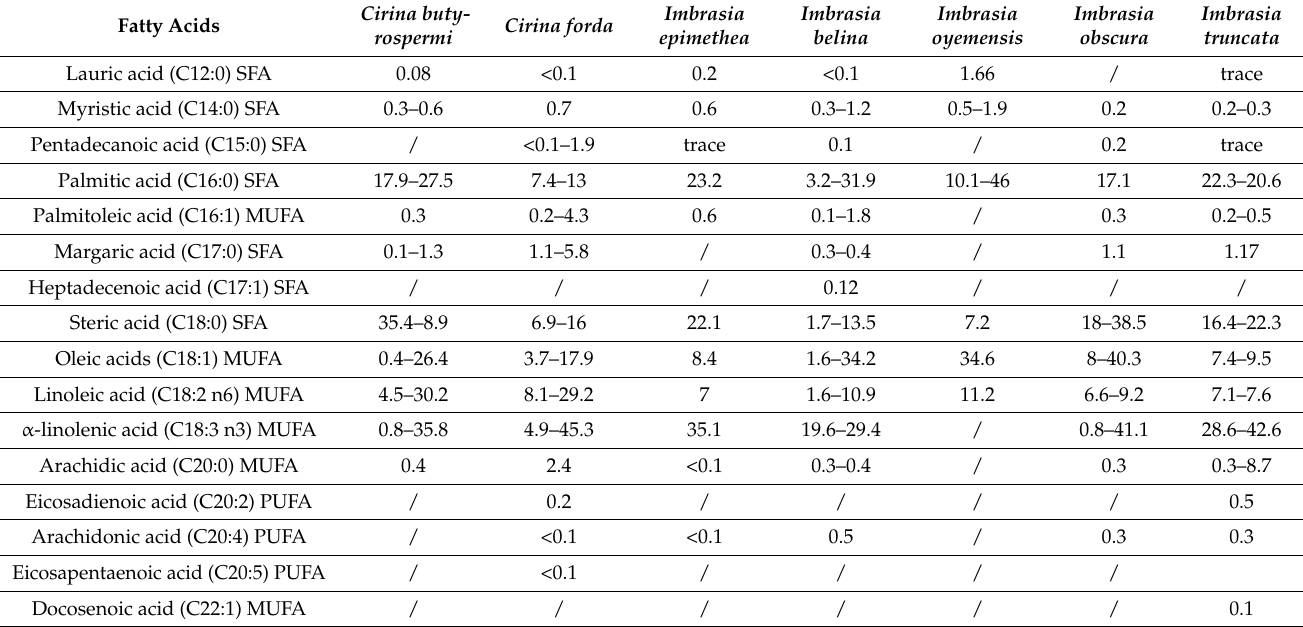
Table 5. Fatty acid composition of caterpillars consumed in sub-Saharan Africa (% on dry matter basis).